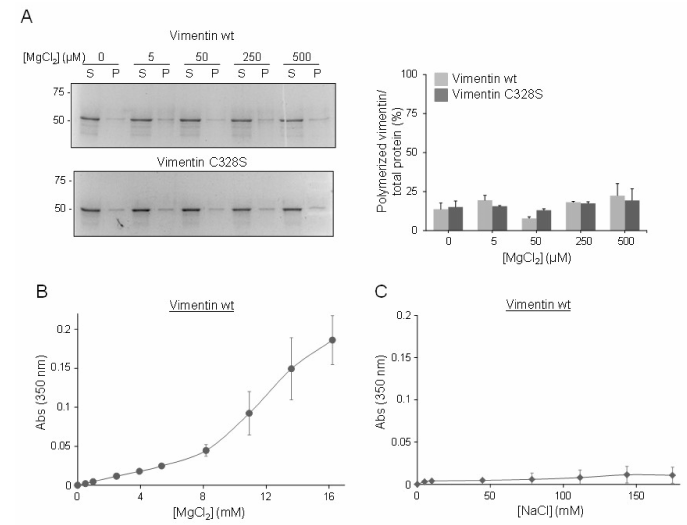
Figure 3. E ff ect of MgCl 2 or NaCl on vimentin polymerization. ( A ) Vimentin wt or C328S in 5 mM PIPES-Na pH 7.0, 0.2 mM DTT, was incubated with the indicated concentrations of MgCl 2 for 1 h at r.t., and polymerization was assessed by ultracentrifugation as above. Supernatant (S) and pellet (P) fractions, containing soluble and polymerized vimentin, respectively, were analyzed by SDS-PAGE and staining with Sypro-Ruby. The percentage of polymerized vimentin for every condition is shown in the graph as average values ± SEM from two assays. ( B , C ) Vimentin wt was incubated with increasing concentrations of MgCl 2 ( B ) or NaCl ( C ) and turbidity measured at 350 nm at r.t. Results are the mean ± SD of three ( B ) or two ( C )